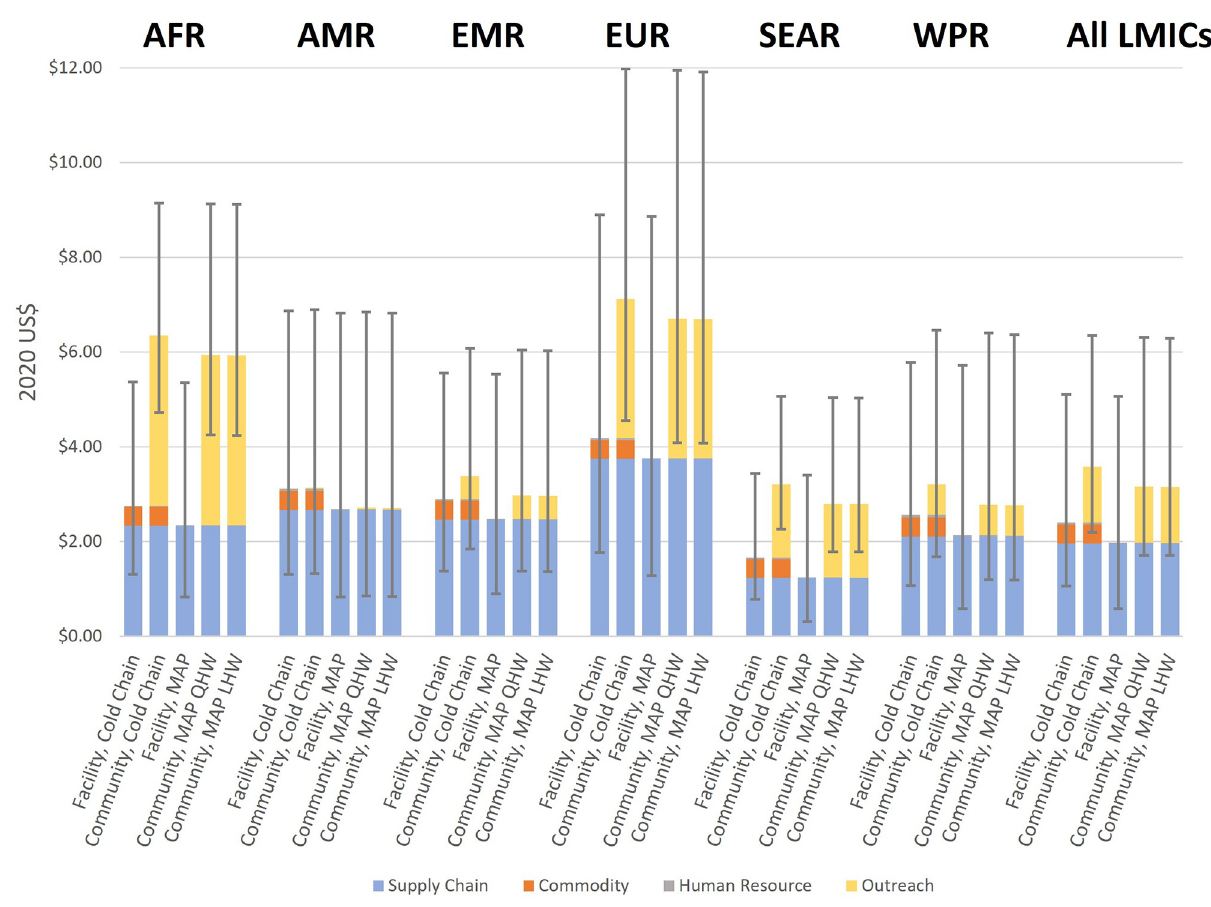
Fig 1. Component breakdown of modelled per-dose vaccination cost estimates for each WHO region. Note: Error bars represent uncertainty range used in analysis. MAP costs exclude commodity components. Abbreviations: AFR, African WHO Region AMR, American WHO Region; EMR, Eastern Mediterranean WHO Region; EUR, European WHO Region; LHW, lay health worker; LMICs, low- and middle-income countries; MAP, microarray patch; QHW, qualified health worker; SEAR, Southeast Asian WHO Region; US$, United States Dollar; WHO, World Health Organization; WPR, Western Pacific WHO